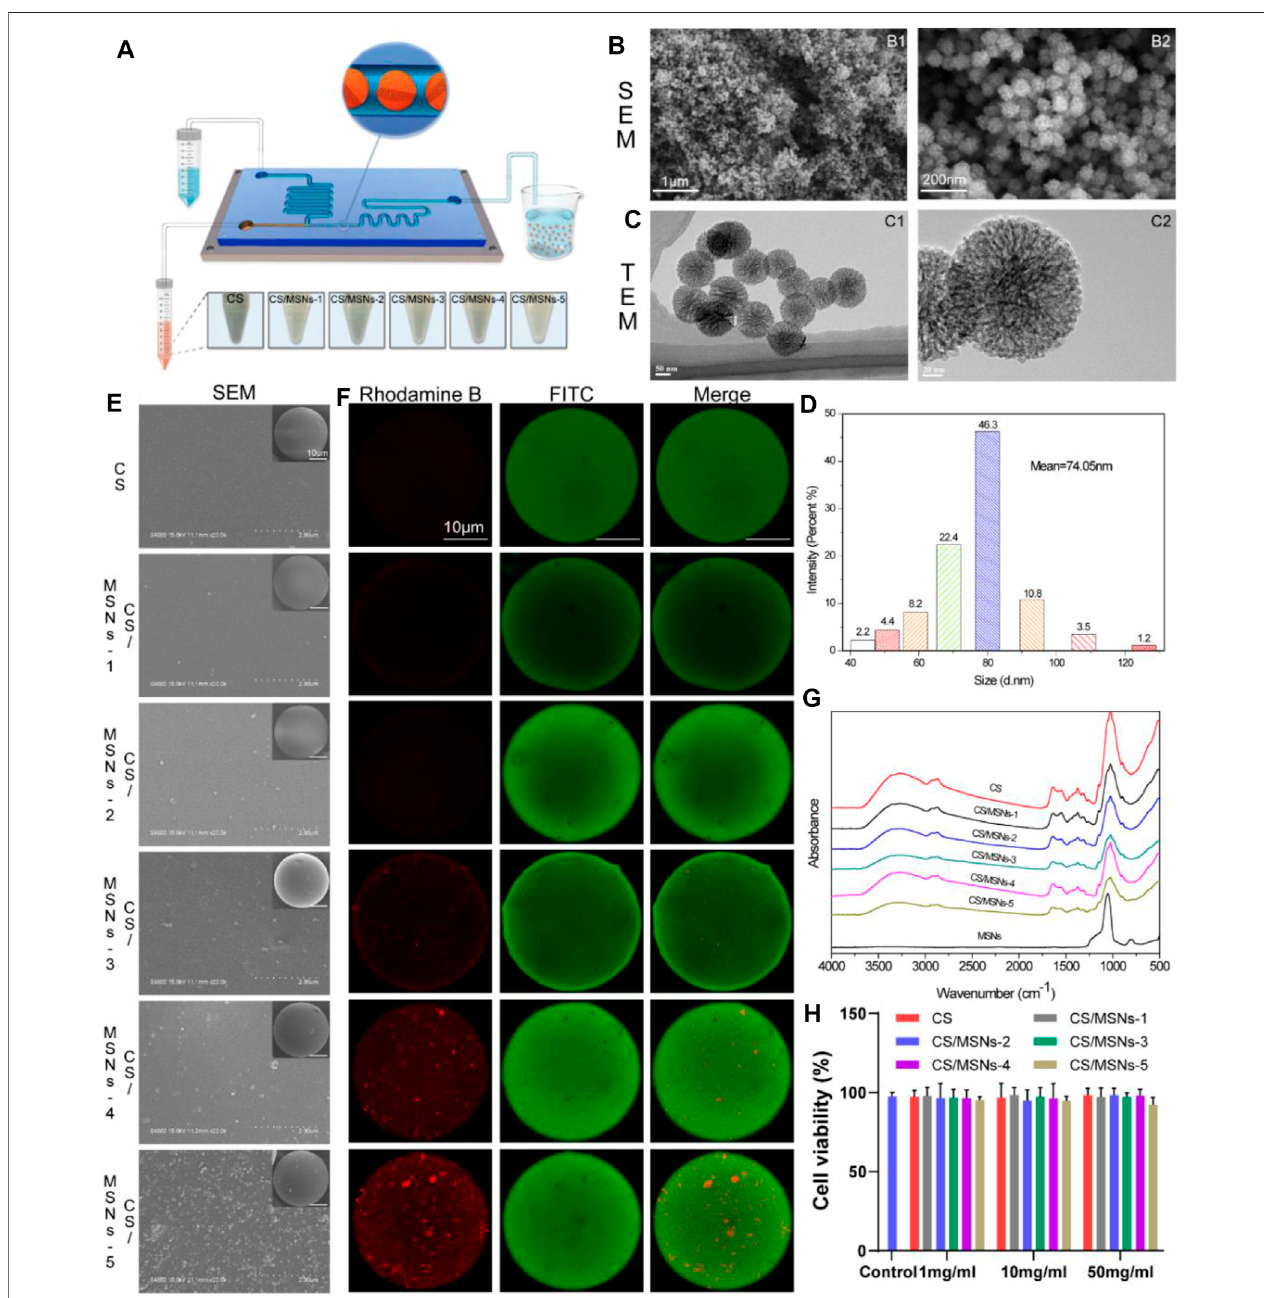
FIGURE 2 | Preparation and characteristics of MSNs and CS/MSNs composite microspheres. (A) The schematic illustration of the micro fl uidic chip for fabrication of CS/MSNs composite microspheres. (B) SEM images of MSNs. (C) TEM images of MSNs. (D) The size distribution of MSNs. (E) The SEM images of CS/MSNs composite microspheres. (F) The fl uorescent images ofCS/MSNs compositemicrospheres. (G) FTIR spectraofCS/MSNscomposite microspheres. (H) Cytotoxicityof different concentrations of CS/MSNs composite microspheres (Data shows mean ± SD, n = 5).